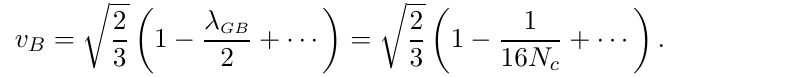
= f 1 = 8 ; (cid:0) 1 ; (cid:0) 4 g depicted in black, GB , the dispersion relation curves pass through the GB